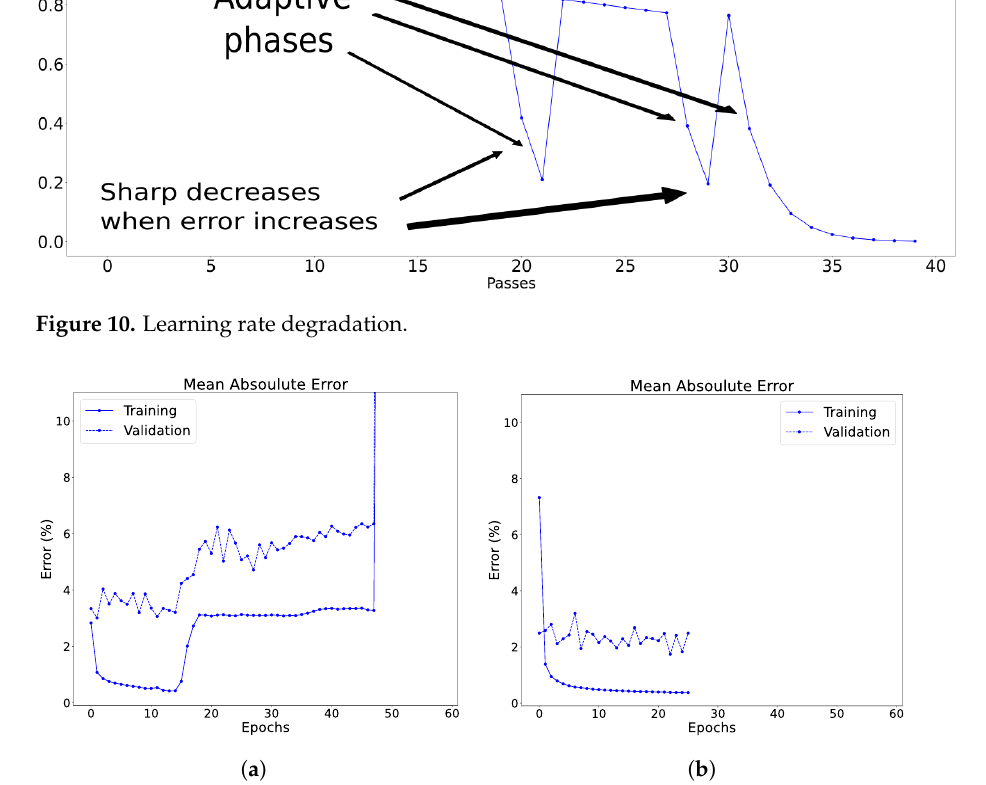
Figure 11. Training process comparison with and without a recovery algorithm. ( a ) Model training process with no rollbacks; ( b ) model training process with a rollback if the current error is higher than the previous error.